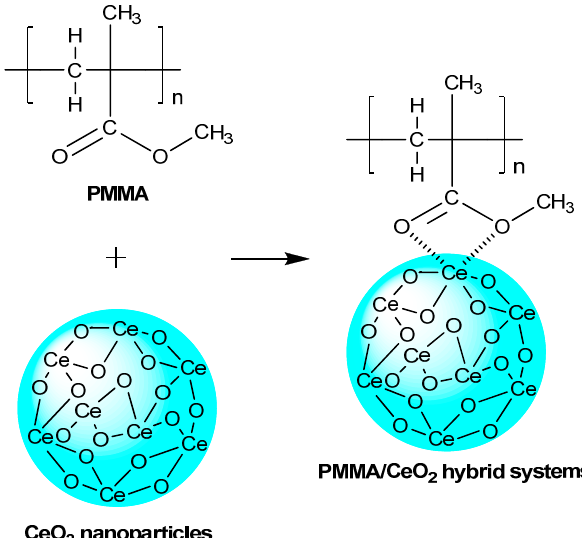
Figure 3. Proposed interaction between the PMMA matrix and CeO 2 nanoparticles.